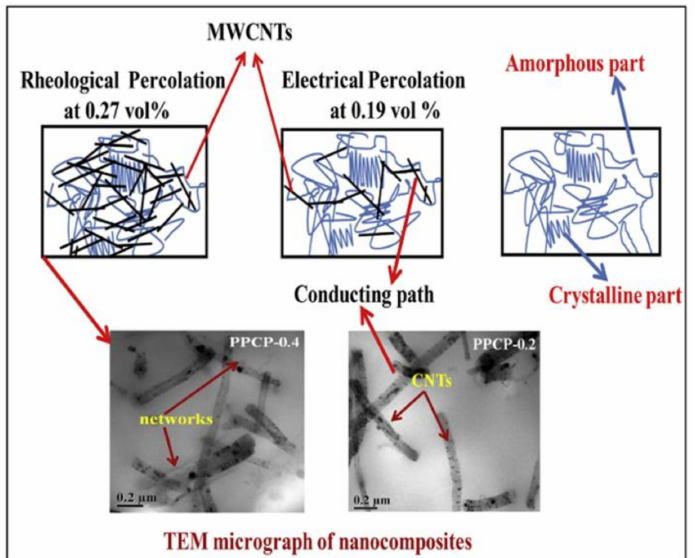
Figure 19. Schematic representation of the rheological and electrical percolation of nanocomposites along with the TEM micrographs [62]. Reproduced with permission from Ref. [62]. Copyright (2016), Polymer